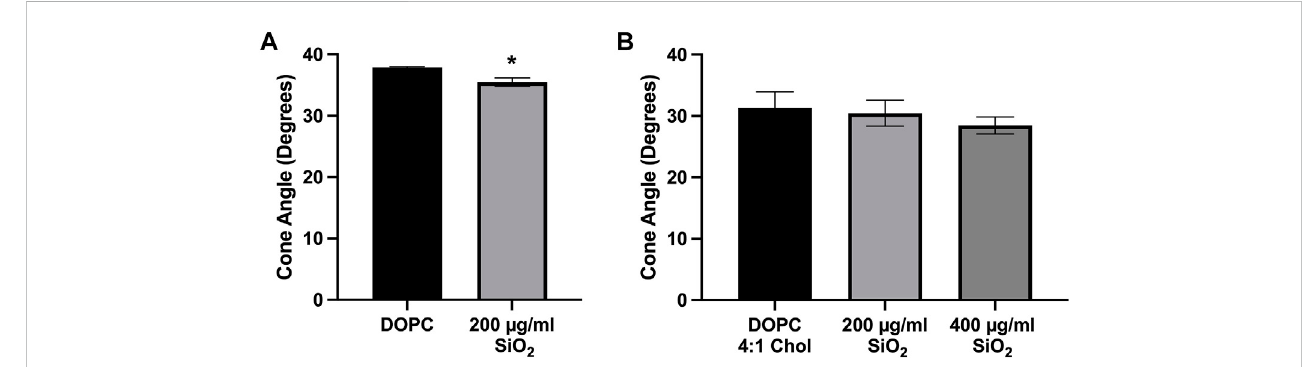
FIGURE 6 Time-resolved Anisotropy of Di-4ANEPPDHQ in Liposomes. (A) Pure DOPC liposomestreated with silica (200 μ g/mL) for 2 h. (B) DOPC liposomes with cholesterol4:1 Mratioincubatedwithsilica(200 μ g/mLand400 μ g/mL)for2 hbeforeanisotropymeasurementsweretaken.Dataexpressedas mean±SEM , n = 3 independent experiments. (A) Analyzed by one-way ANOVA with Dunnett ’ s post hoc test. (B) Analyzed with a two-tailed unpaired t -test. * p <